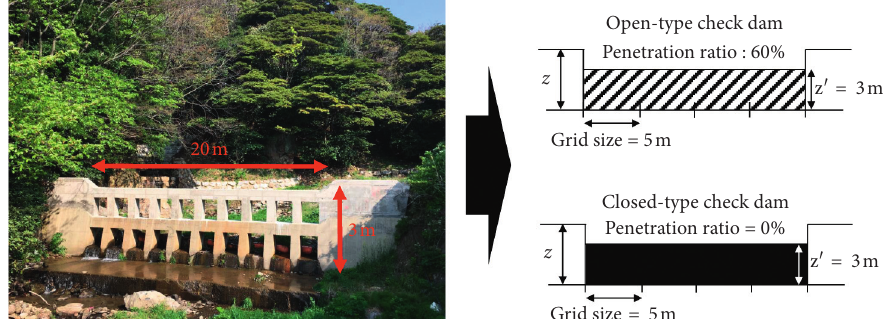
Figure 6: Application of the check